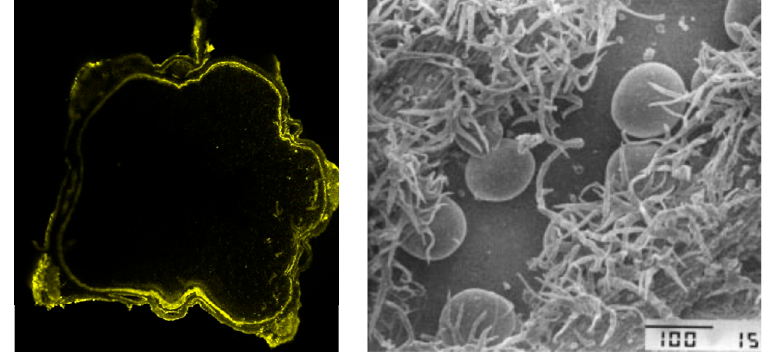
Figure 4. Oil storage location of caraway (subcutaneous) and lavender [11] (surface near trichomes).